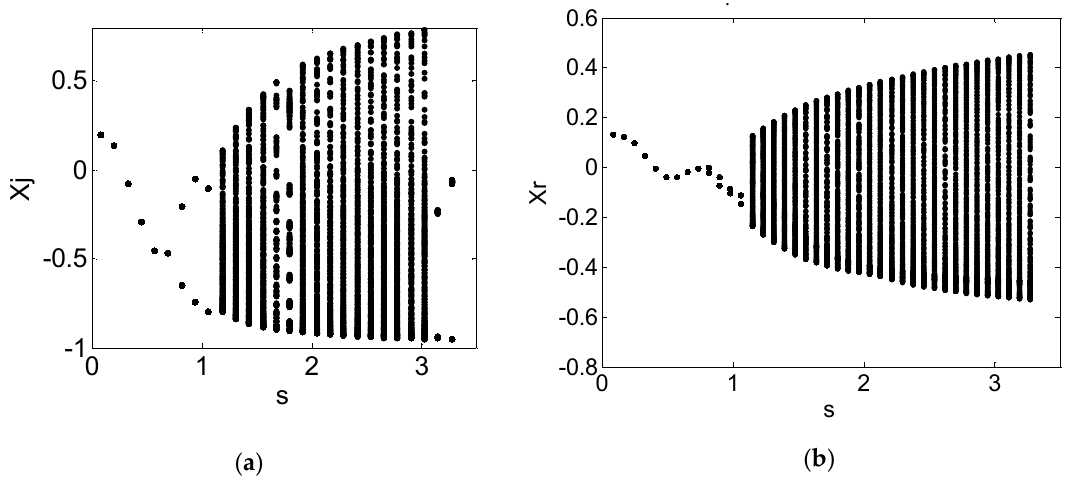
Figure 5. Bifurcation diagram of the axis and floating ring when λ = 0.075: ( a ) bifurcation diagram of journal; ( b ) bifurcation diagram of floating ring .